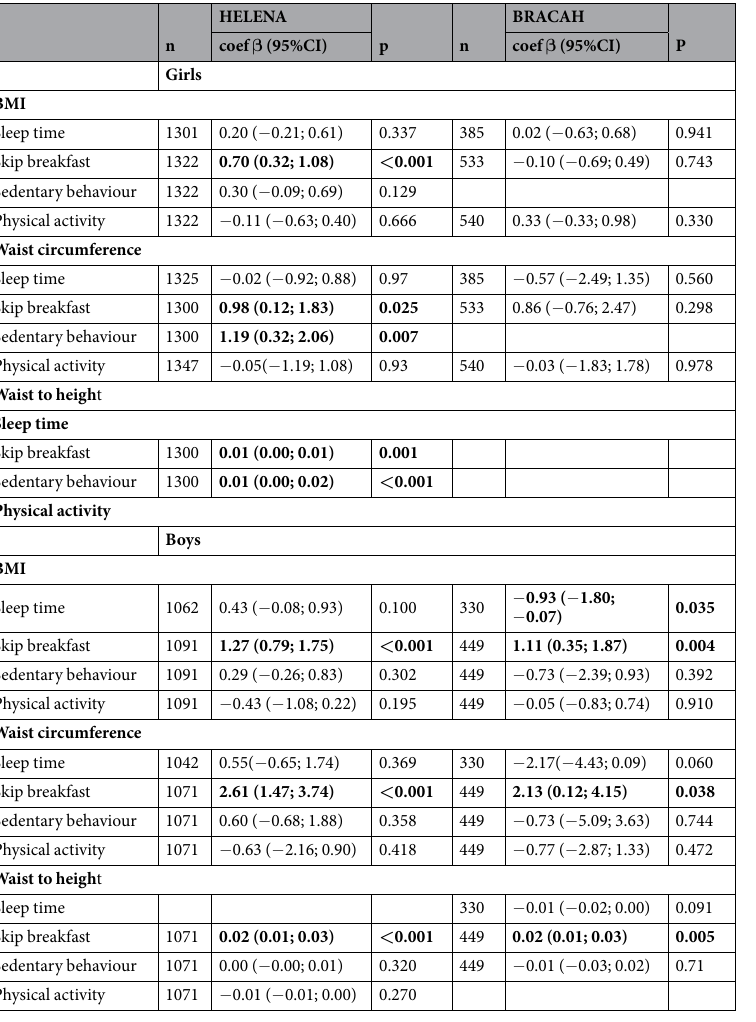
Table 2. Adjusted * association between EBRBs and general and abdominal obesity, among adolescents studied from HELENA-CSS and BRACAH study. Adjusted by potential confounders: center (only in HELENA-CSS), age and education mother. Significant associations are in bold. EBRBs: energy balance-related behaviours, BMI: body mass index, HELENA-CSS: Healthy Lifestyle in Europe by Nutrition in Adolescence cross-sectional study. BRACAH study: Brazilian Cardiovascular Adolescent Health study, 95%CI: confidence interval, coef β : beta